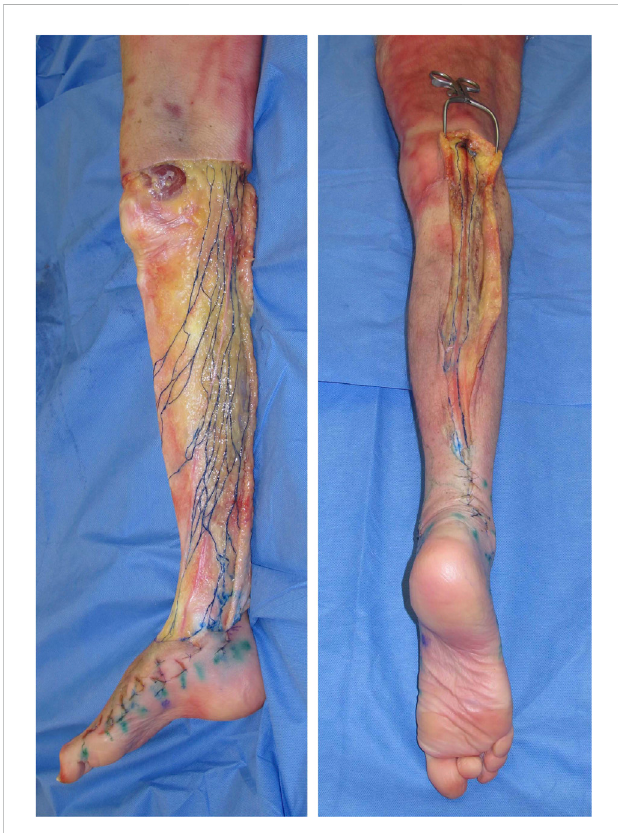
FIGURE 1 The lower extremity of a cadaver injected with dye into the super fi cial lymphatic vessels shows the medial pathway (left) and posterior pathway running along the small saphenous vein